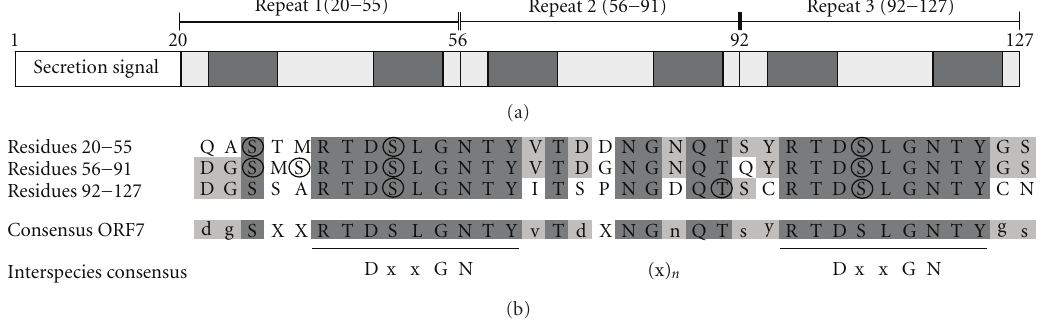
Table 3: BLAST search for proteins containing the DxxGN( x )